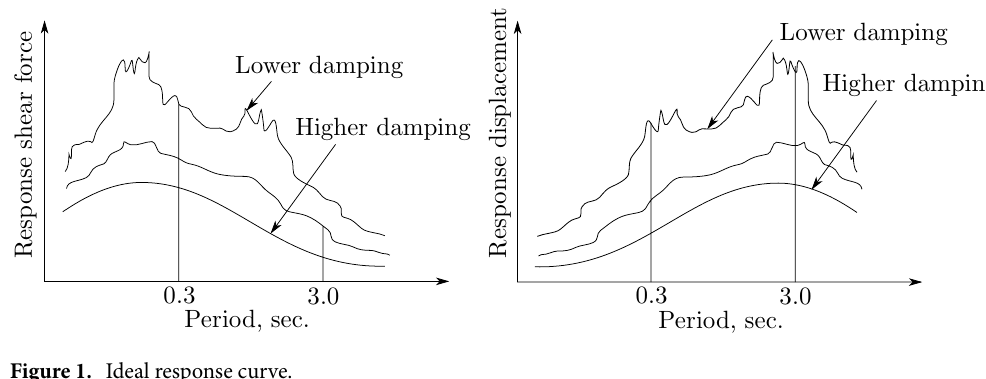
Figure 1. Ideal response